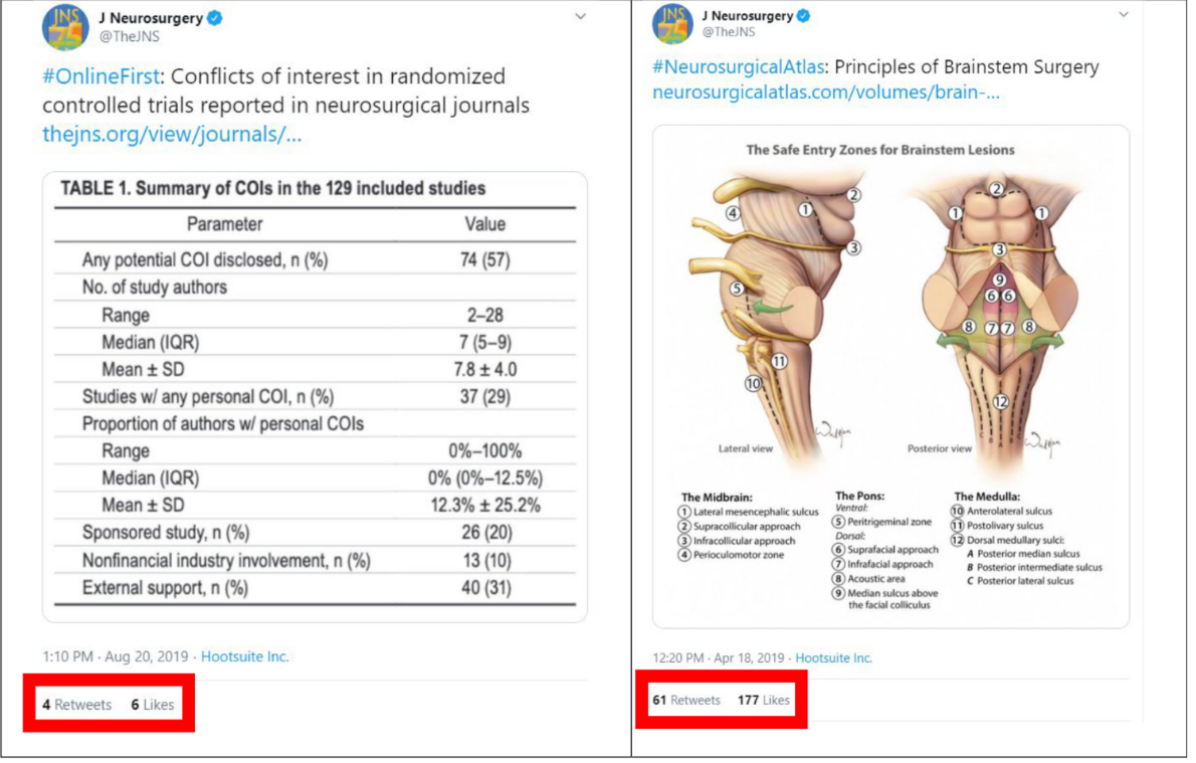
Figure 2. Differences in retweets and likes between #OnlineFirst and #NeurosurgicalAtlas.